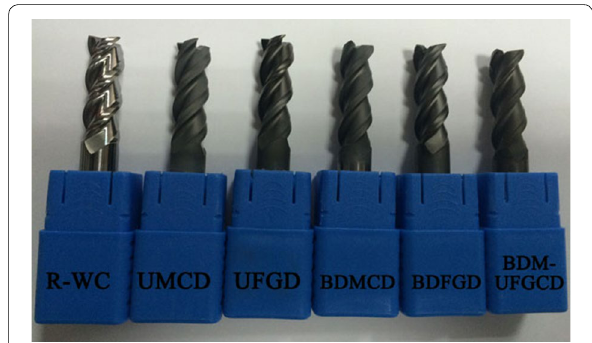
Figure 1 Photographs of the uncoated and different diamond coated milling